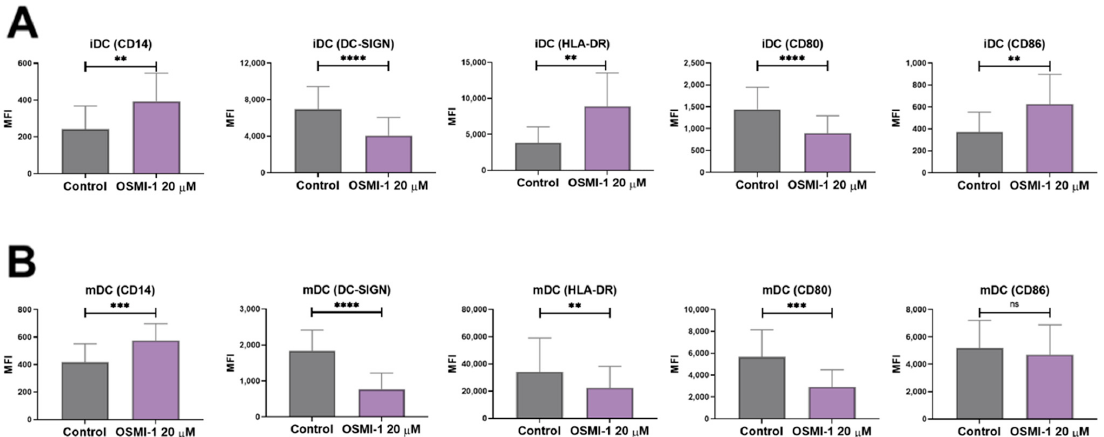
Figure 3. Characterisation of specific DC surface markers in the presence of OSMI-1. ( A ) Immature moDCs differentiated from monocytes for 6 days in the presence or absence of OSMI-1. ( B ) Mature moDCs were generated by the addition of the cytokine cocktail for 2 days either from immature moDCs (control) or immature OSMI-1-moDC. The activation of later was carried out in the presence of OSMI-1. Shown are mean MFI values ± SD of n = 8–11 independent experiments. Statistical significance between individual pairs was calculated using Student’s t -test; p -value < 0.05 was considered statistically significant (** p < 0.01; *** p < 0.001; **** p < 0.001; ns, nonsignificant). iDCs, immature moDCs; mDCs, mature moDCs.